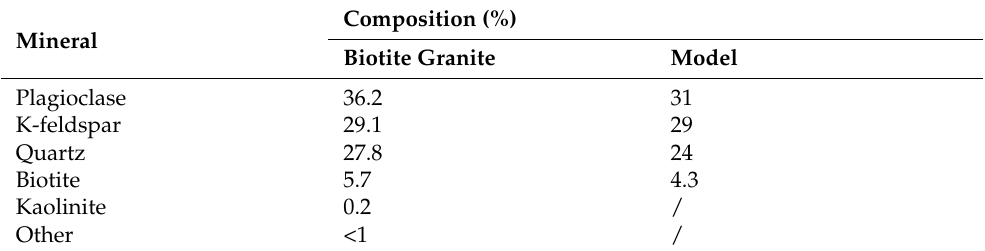
Table 1. Mineral composition of Biotite granite and simulation model.